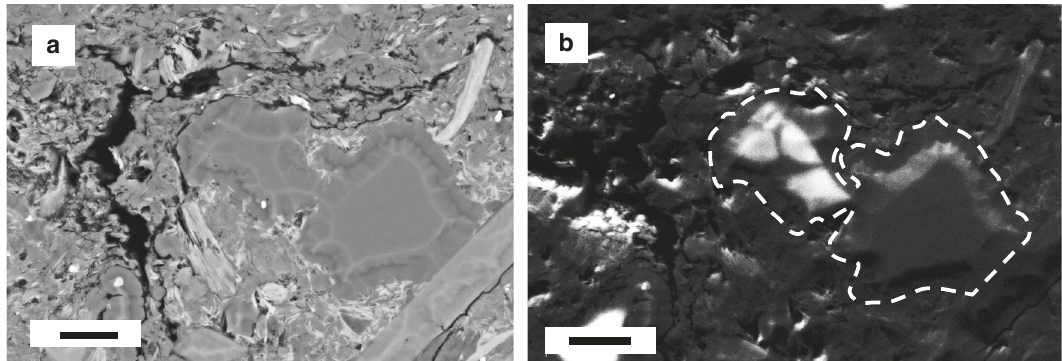
Fig. 4 SEM backscatter and cathodoluminescence images of silica overgrowth cement around quartz grains. a SEM backscatter image showing two 25 µ m quartz grains surrounded by clay sized minerals from Urupunga-4. b SEM cathodoluminescence image illustrating 3 to 4 angular quartz grains that have strong luminescence indicating a detrital origin 46 with non-luminescent silica cement forming overgrowths that appear as silt sized grains. Scale bar = 10 μ